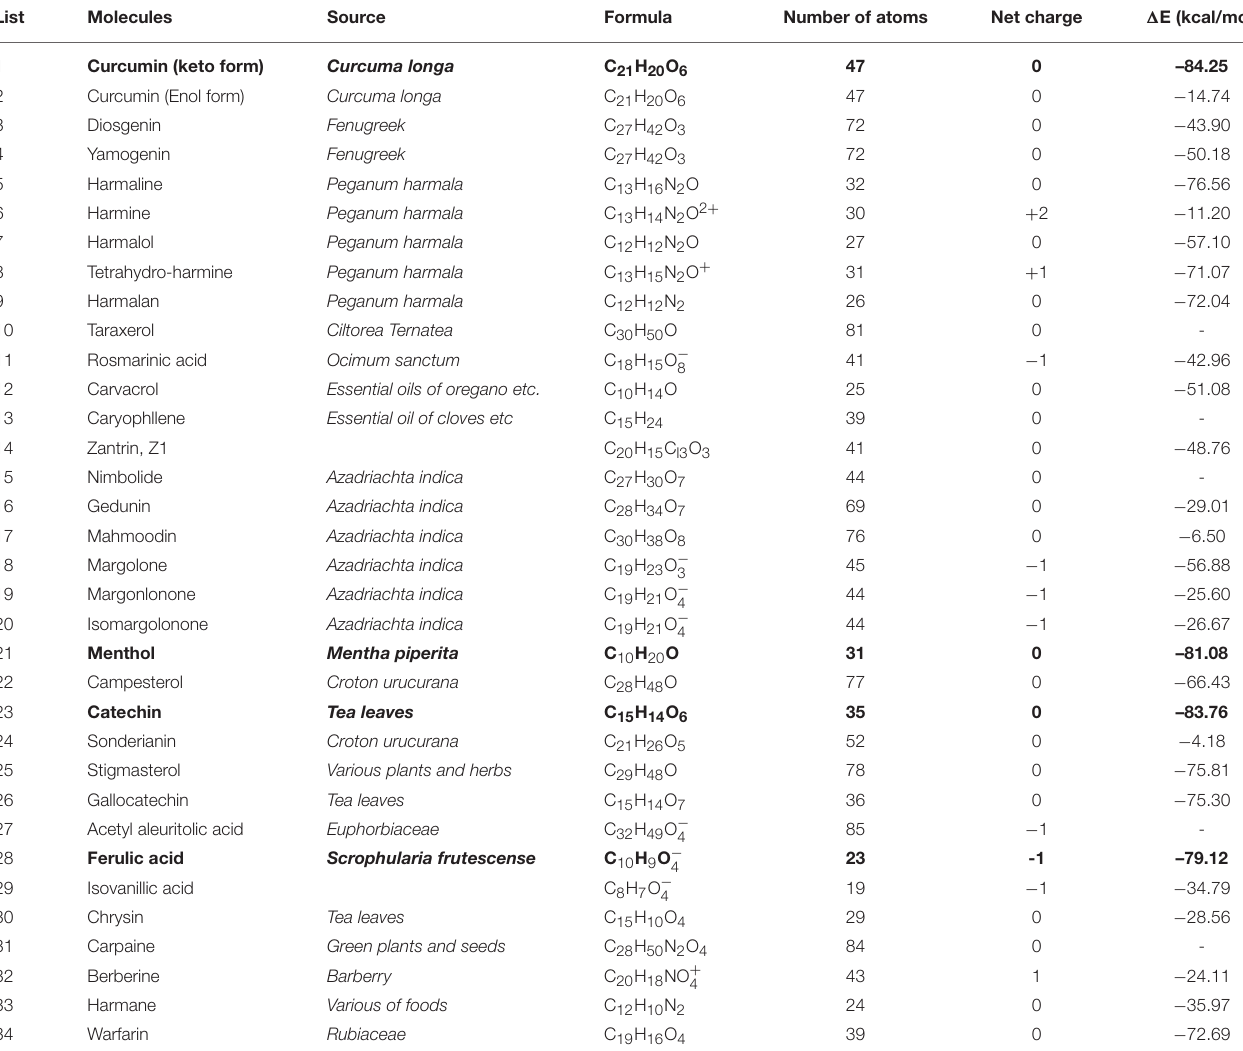
TABLE 1 | Calculated binding energies ( 1 E) of nature compounds obtained using Equation